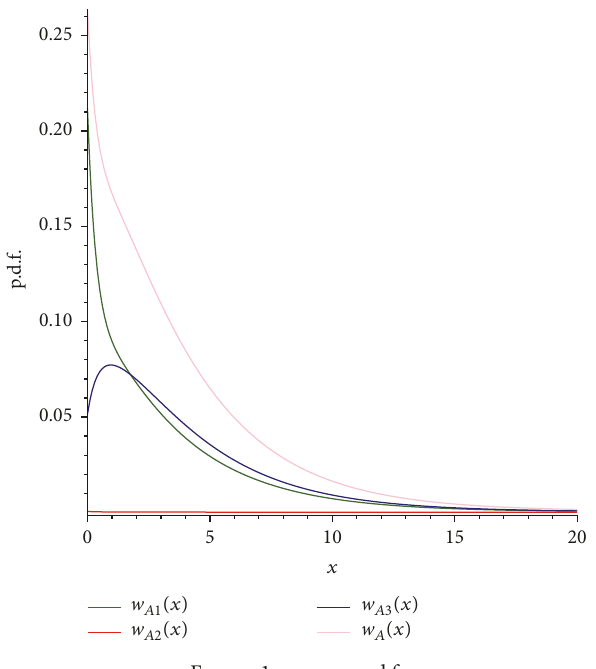
Figure 1: 𝑥 versus